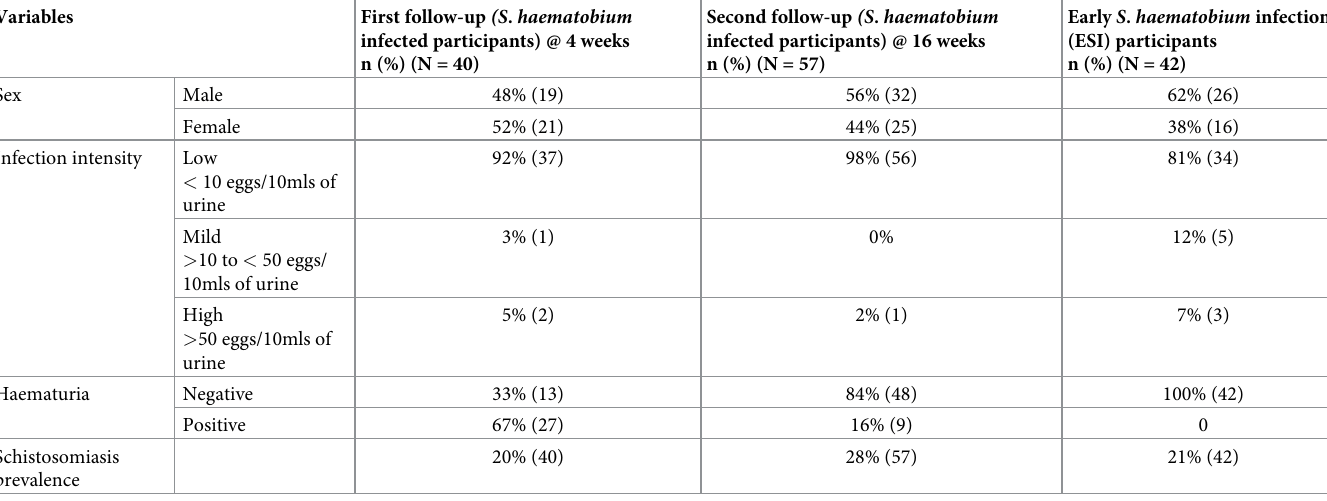
Table 2. Characteristics of study participants at follow-ups.